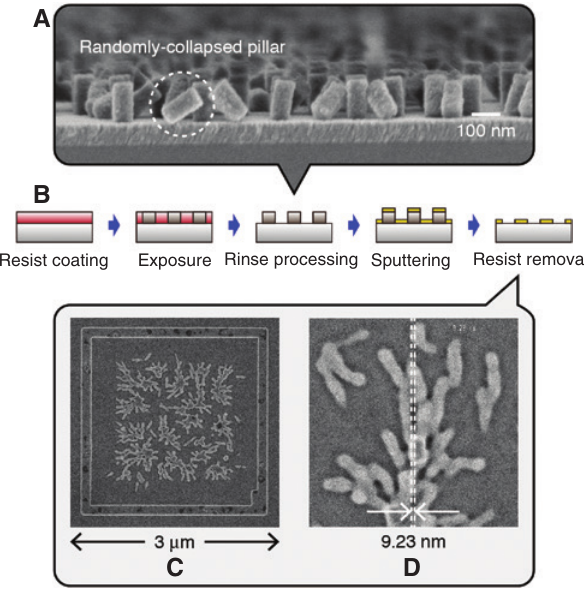
Figure 1: (A) SEM image of collapsed resist pillars. (B) Common procedure for electron-beam lithography. (C) Entire region of the fabricated silicon pattern based on the random collapse of resist pillars and (D) a magnified view of an area of the pattern. Source: Adapted with permission from Macmillan Publishers Ltd: Scientific Reports